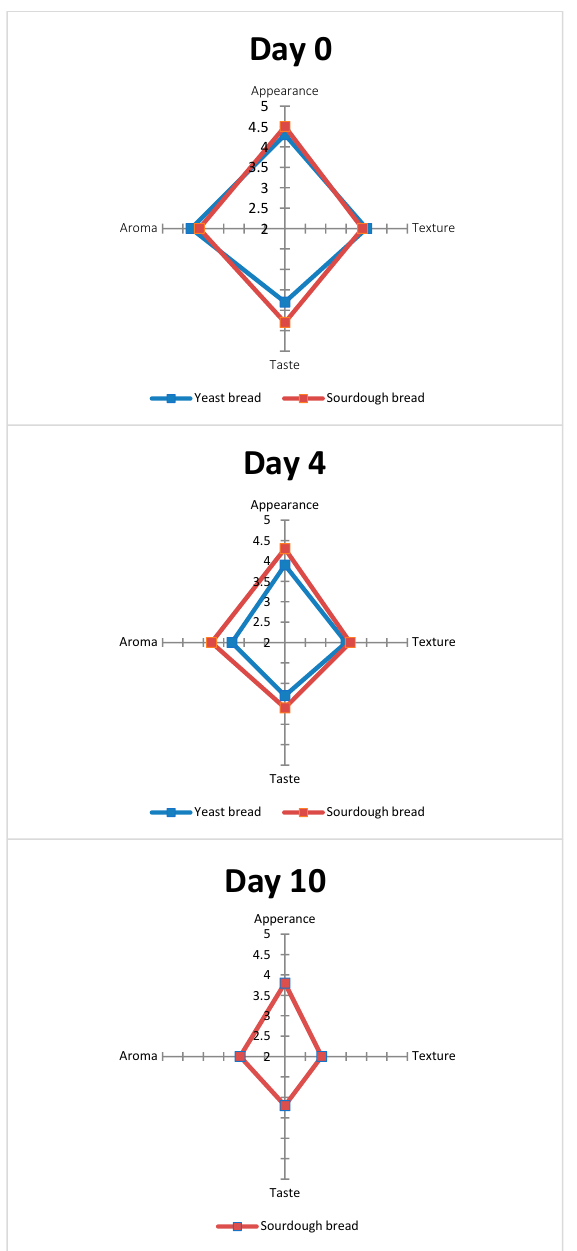
Figure 6. Sensory evaluation of yeast and sourdough breads in the form of star diagrams at different storage times.